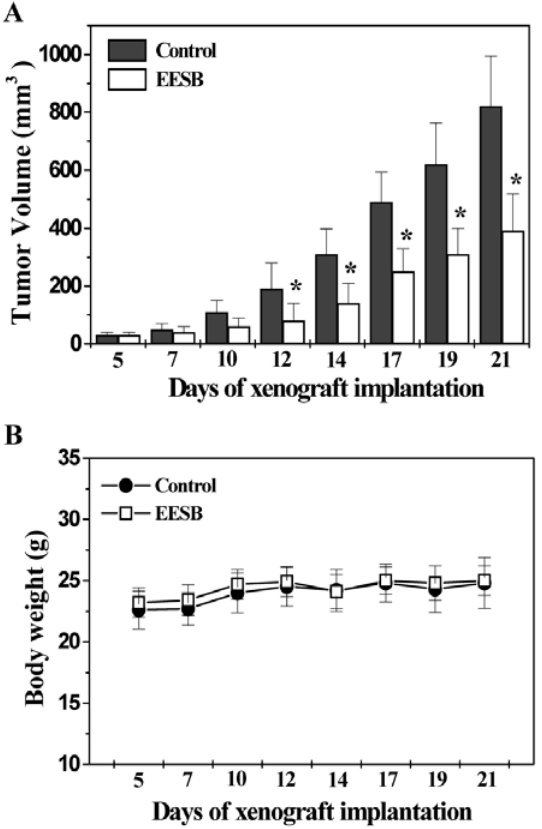
Figure 1. Effect of Ethanol extract of Scutellaria barbata D. Don (EESB) on tumor growth in colorectal cancer (CRC) xenograft mice. After tumor development, the mice were given intra-gastric administration with 2g/kg of EESB or saline daily, 5 days a week for 16 days. Tumor volume ( A ) and body weight ( B ) were measured during the experiment. Data shown were averages with S.D. (error bars) from 10 individual mice in each group. * p < 0.05, versus